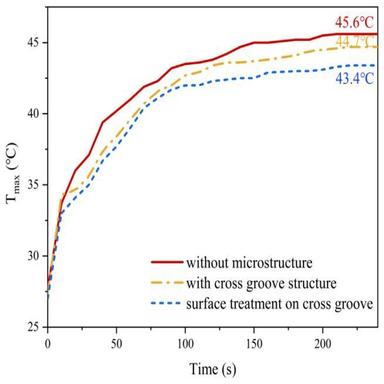
Working temperatures of LED chip with the Si3N4/diamond heat dissipation material of different surface microstructures.